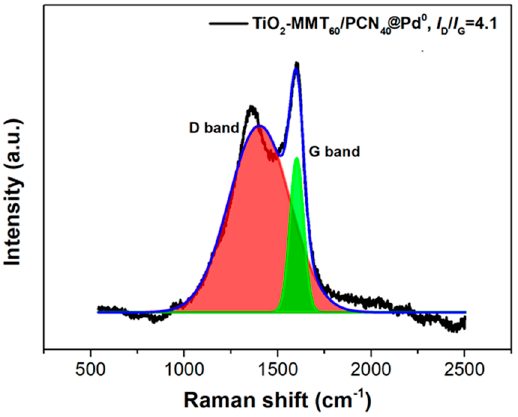
Figure 4. Raman shift of the TiO 2 -MMT 60 /PCN 40 -Pd 0 nanocomposites.